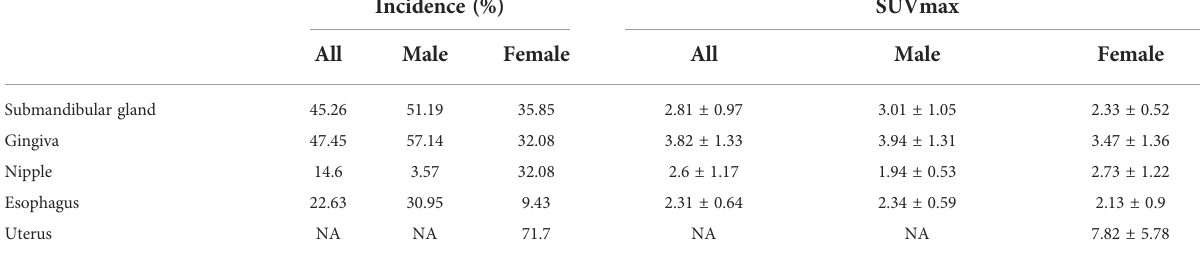
TABLE 2 Physiological uptake of 68 Ga-FAPI-04.